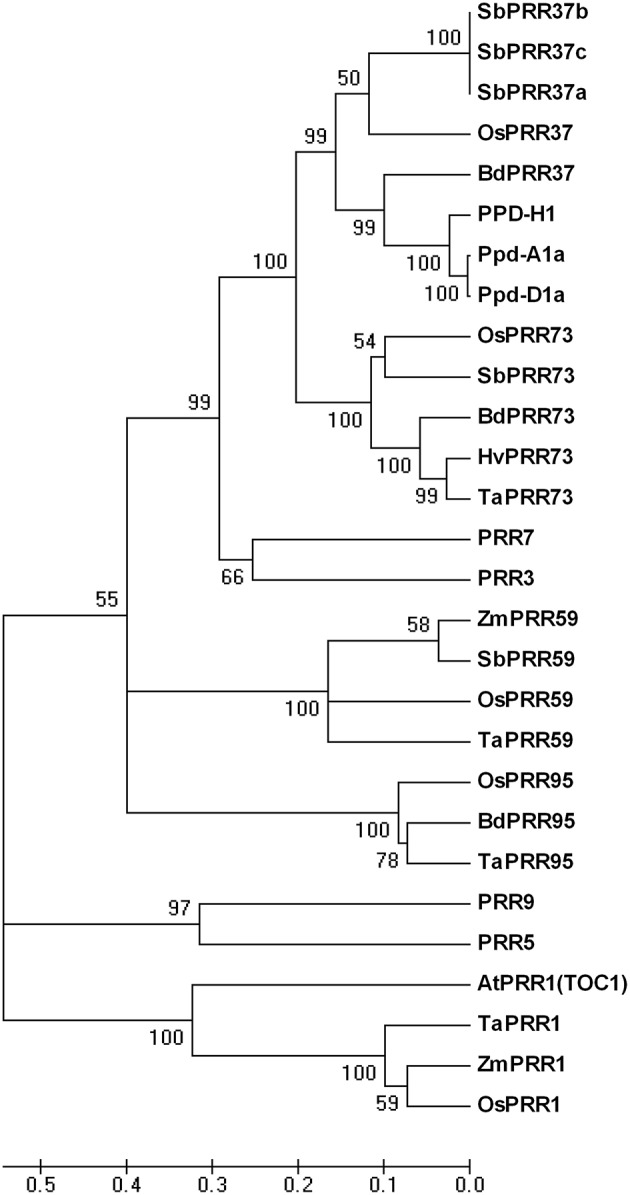
Phylogenetic tree of PRR proteins from Triticum aestivum, Oryza sativa, Hordeum vulgare, Sorghum bicolor, Brachypodium distachyon, Zea mays, and Arabidopsis thaliana. Accession no. of Oryza sativa, Hordeum vulgare, Sorghum bicolor, Brachypodium distachyon, Zea mays, and A. thaliana proteins were obtained from NCBI; Triticum aestivum Ppd-D1a, ABL09464; and Ppd-A1a, ABW93666. The amino acid sequences of TaPRR1, TaPRR59, and TaPRR95 were predicted from the D genome scaffold.